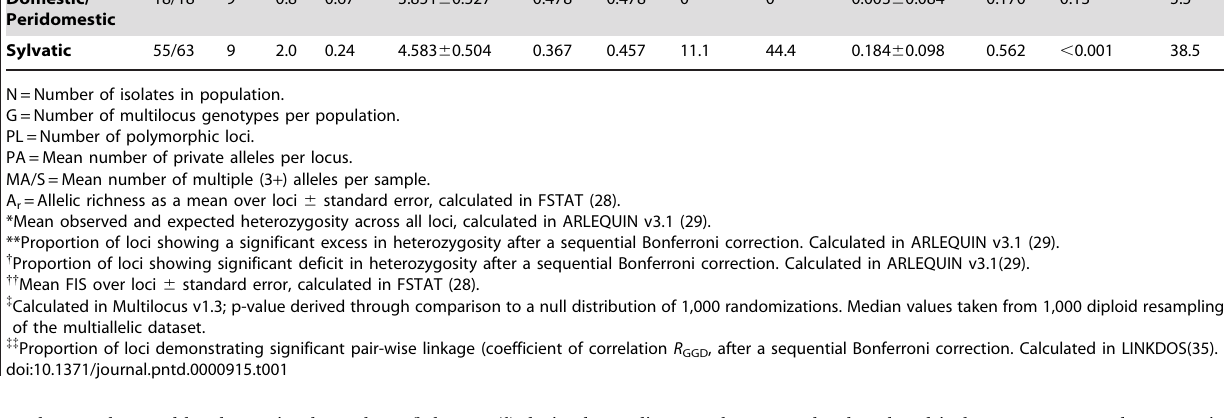
Population Domestic/ Peridomestic Sylvatic